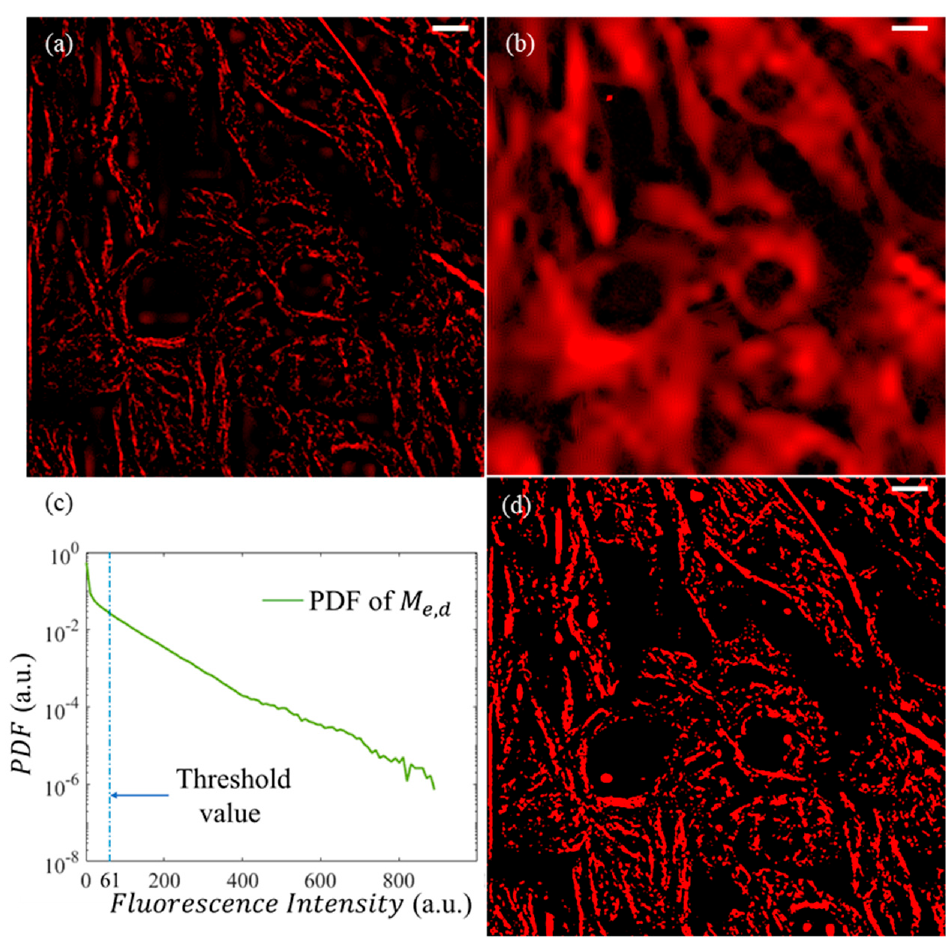
Figure 9. Extraction of microtubule structures by DWT. ( a ) Extracted components after DWT analysis. ( b ) Undesired components that should be abandoned. ( c ) Probability density function (PDF) of M e , d . ( d ) Logical matrix ( M e , dL ) of the structure after DWT analysis. The white scale bars represent 10 µ m. When ξ = 0.5, the applied Gaussian radium for deconvolution ∆ r was only half of the theoretical value r ⊥ . The continuous structures of the logical matrix became fragmented and hollow (Figure 10a). When ξ was increased to 2.5, significant shrinkage of the logical matrix structures was achieved with at the expense of continuous network structures (Figure 10b). The optimal outcome was obtained when kmax and the damping coefficient were 10 and 0.01, respectively (Figure 10e). It should be noted that before applying the DWDC method, the optimal ξ must be calculated, since a mismatching ξ can lead to invalid or even over-processed images. For different optical systems, the PSF and the optimal ξ are different. For a different optical system, it may take a few hours to locate the optimal ξ